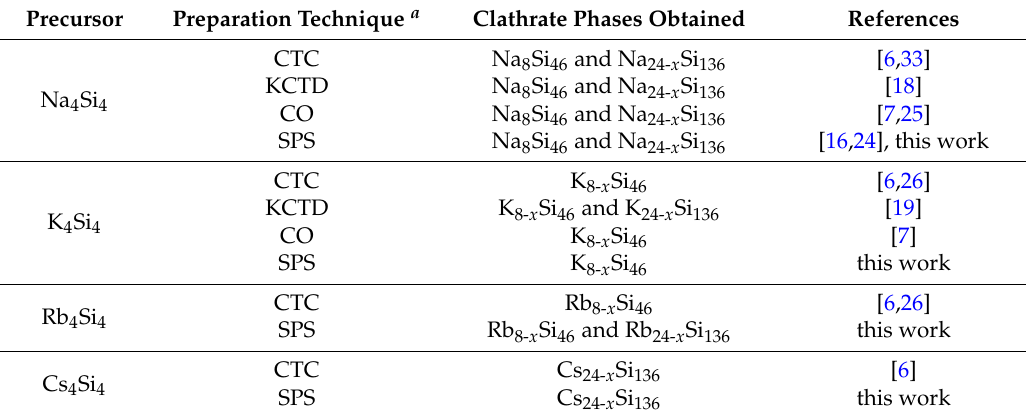
Table 4. Clathrate phases obtained by different synthesis techniques from M 4 Si 4